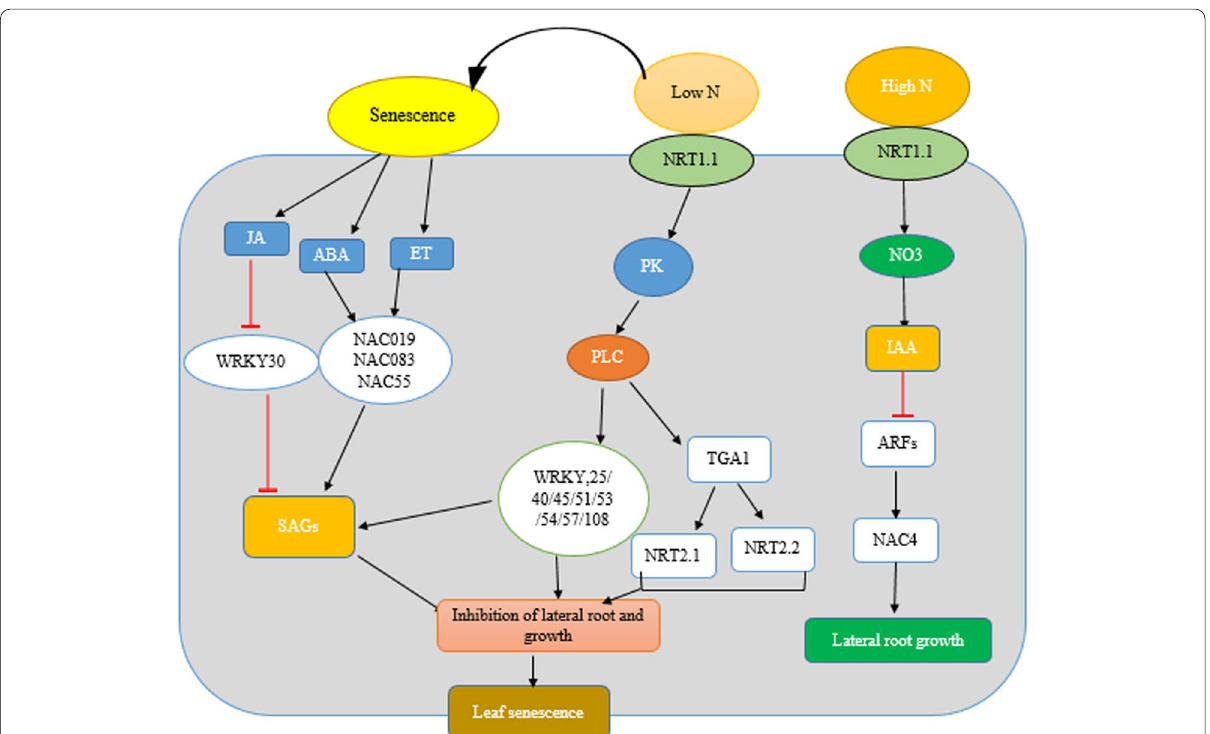
Fig. 2 Schematic diagram showing the regulation of multiple pathways in response to high and low nitrate conditions in plants. Only the paths discussed in the present study are illustrated. Signaling pathways lead to the onset of leaf senescence. Black arrows indicate positive regulation of ABA; abscisic acid; IAA, indole-3-acetic acid; JA, jasmonic acid; SAGs, genes associated with senescence; TGA1; TGACG motif-binding factor, NRT, nitrate transporter; PLC, phospholipase C; ARF, auxin response factor transcription factors, and red lines indicate a negative signal as an inhibitory effect. Low nitrate and extremely low nitrate conditions have stimulatory and inhibitory effects on LR development, respectively, while high NO3 supply has an inhibitory effect on LR